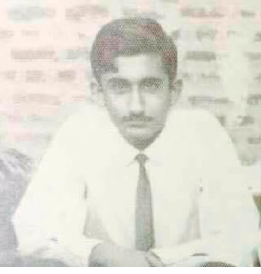
Figure 1. Maulana Tariq Jamil as a college student, prior to his profound conversion